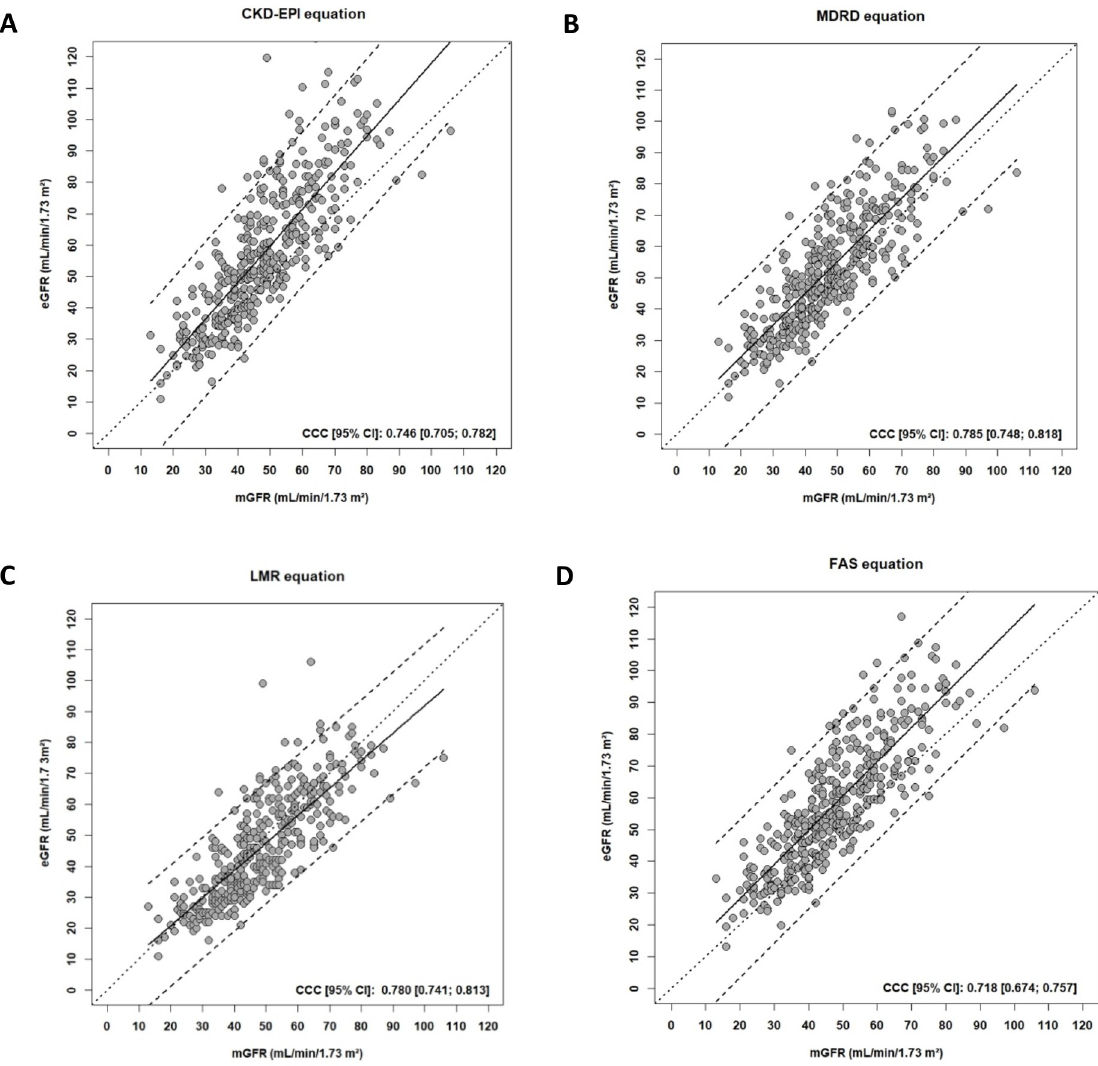
Fig 3. Scatterplots showing, for each equation, the estimated GFR versus the measured GFR (in mL/min/1.73 m 2 ) using the different equations CKD-EPI (A), MDRD (B), LMR (C) and FAS (D). The plain lines represent the line regression. The dashed lines represent the 95% predictive confidence limits. The dotted lines represent the perfect concordance. Abbreviations: mGFR, measured glomerular filtration rate; eGFR, estimated glomerular filtration rate; CCC, Concordance Correlation Coefficient, CKD-EPI, Chronic Kidney Disease Epidemiology Collaboration; MDRD, Modification of Diet in Renal Disease Study; LMR, Lund-Malmo¨ Revised; FAS: Full Age Spectrum; CI: confidence interval.